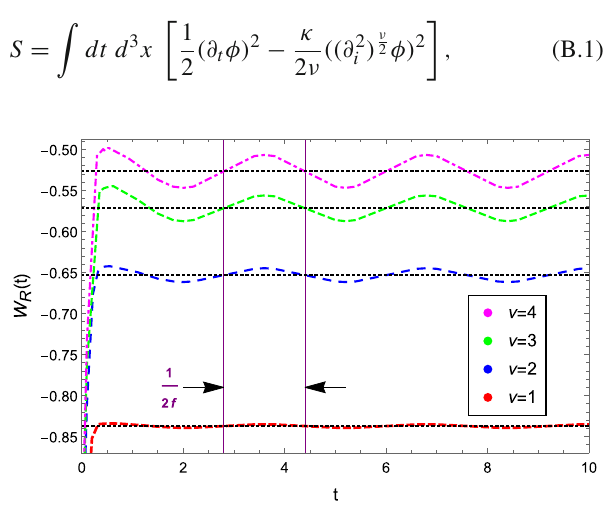
Fig. 7 The expectation value of the Wilson loop in terms of boundary time for ν = 1 , 2 , 3 , 4 , T f = 0 . 0955, k = 0 . 3 and l = 1 . The oscilla- tion frequency is f = 0 . 3125 for all diagrams in this figure. The static potential is V ( l ) = − 0 . 8372 , − 0 . 6532 , − 0 . 5718 and − 0 . 5268 cor- responding to ν = 1 , 2 , 3 and ν = 4, respectively. For ν = 1 , 2 , 3 and ν = 4,wehave2 A = 0 . 0042 , 0 . 0169 , 0 .